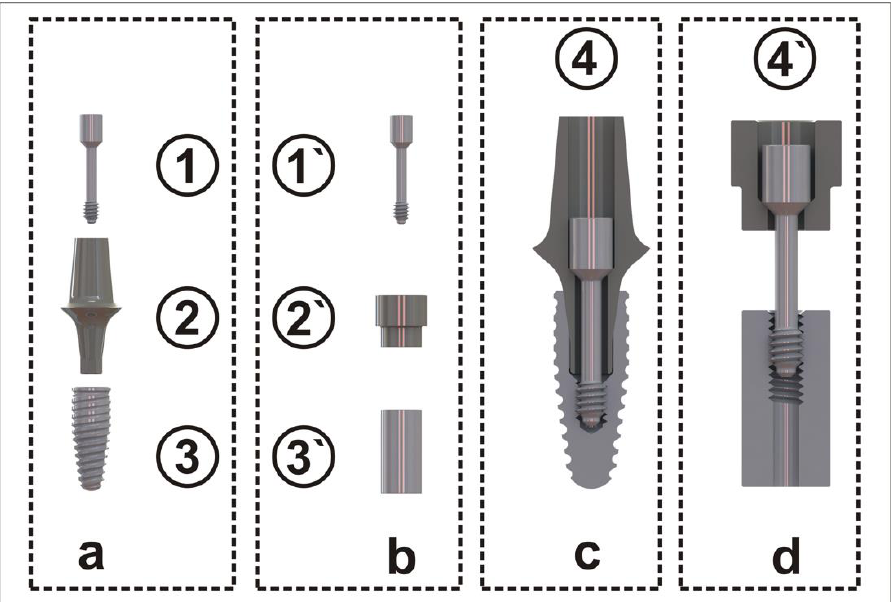
Figure 1. ( a ) Oral implant components and ( b ) analog test specimens (#1 and #1´ abutment screw; #2 abutment/#2´abutment analog; #3 implant/#3´ thread sleeve); ( c ) composition of the components of an oral implant #4 and ( d ) composition of the components of the test specimens #4´.